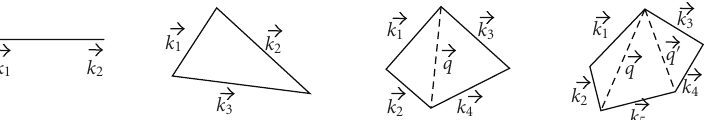
Figure 1: Diagrammatic representation of the 2, 3, 4, and 5-point correlation functions in Fourier space. The dashed lines represent internal